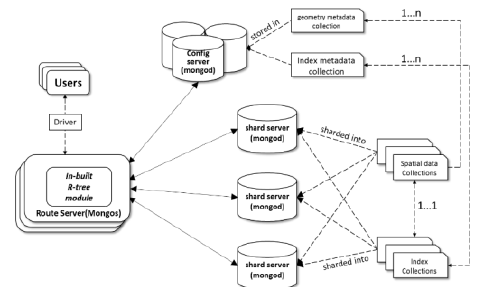
Figure 5. MongoDB’s architecture with R-tree